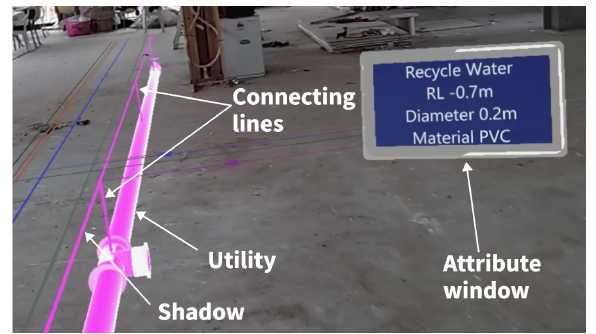
Figure 11. General + Elevator View (a) Slider (b) Utilities are